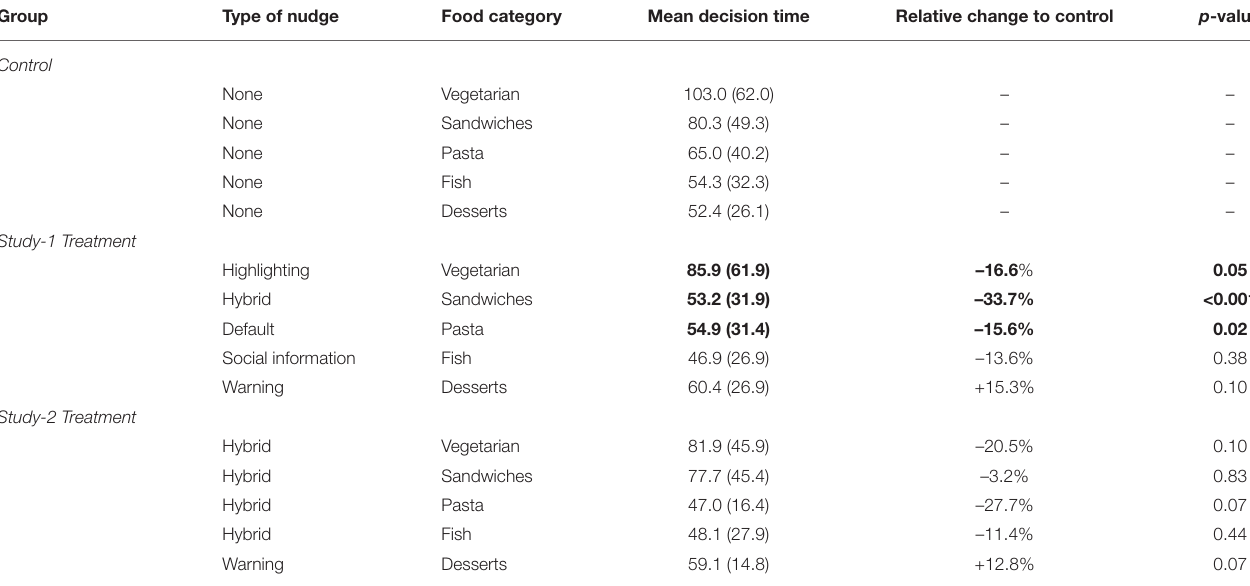
TABLE 5 | Mean and standard deviation for decision times (in seconds) by nudge type and food category. Group